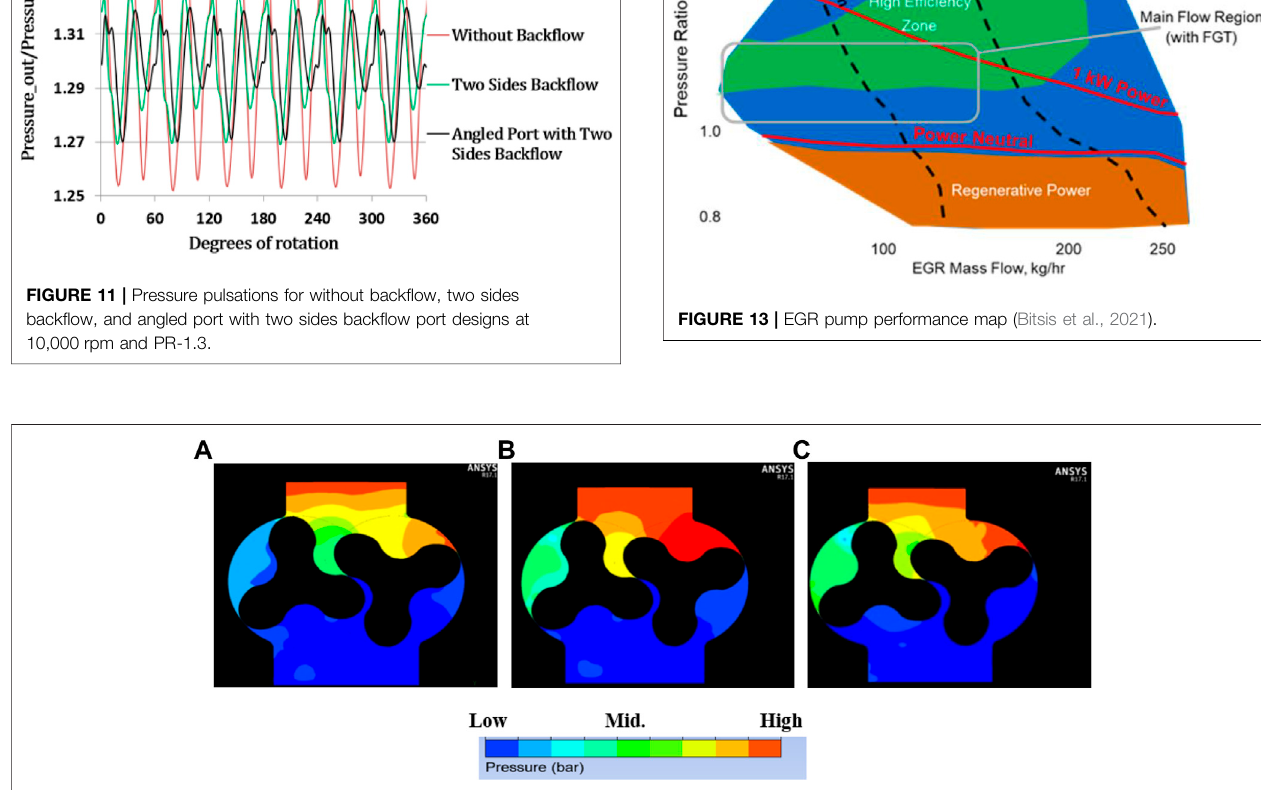
FIGURE 12 | Transfer volume pressurization before opening to outlet port at 10,000 rpm and PR-1.3. (A) Without back fl ow port design. (B) Two-side back fl ow port design. (C) Angled port with two-side back fl ow port design.